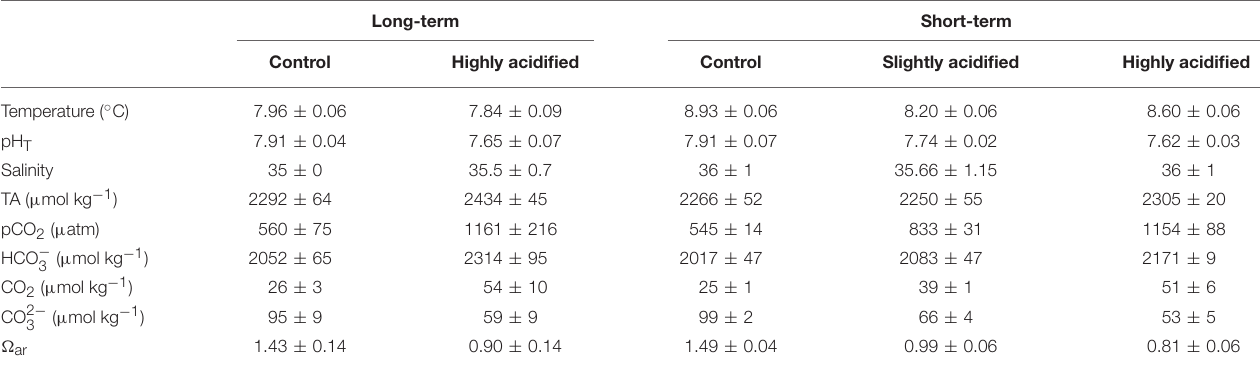
TABLE 2 | Summary of seawater chemistry parameters from each of the treatments for both long-and short-term